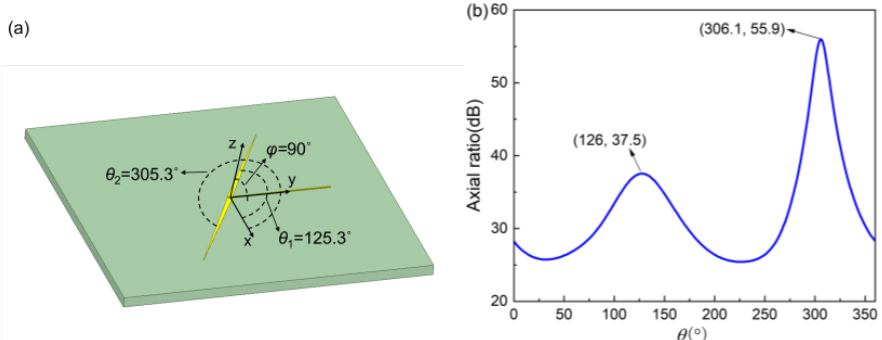
Figure 3. ( a ) Simulation model in the HFSS software; ( b ) axial ratio of each pair of antennas on a single sensor chip.